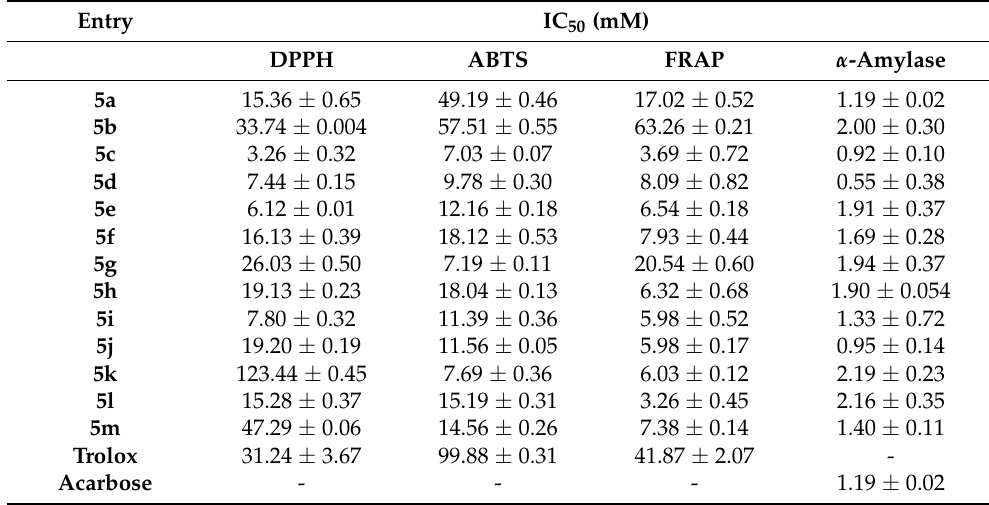
Table 3. In vitro antioxidant and antidiabetic activities of the synthesized